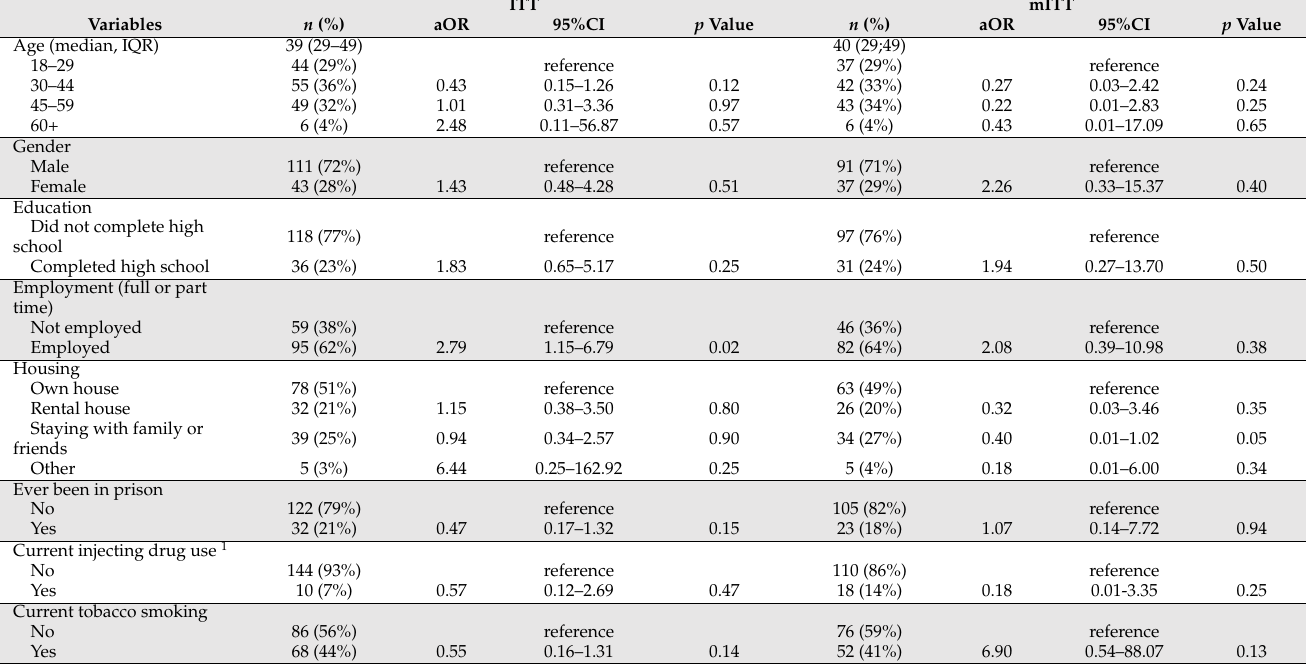
Table 2. Predictors of SVR12 (ITT and mITT); adjusted odds ratio